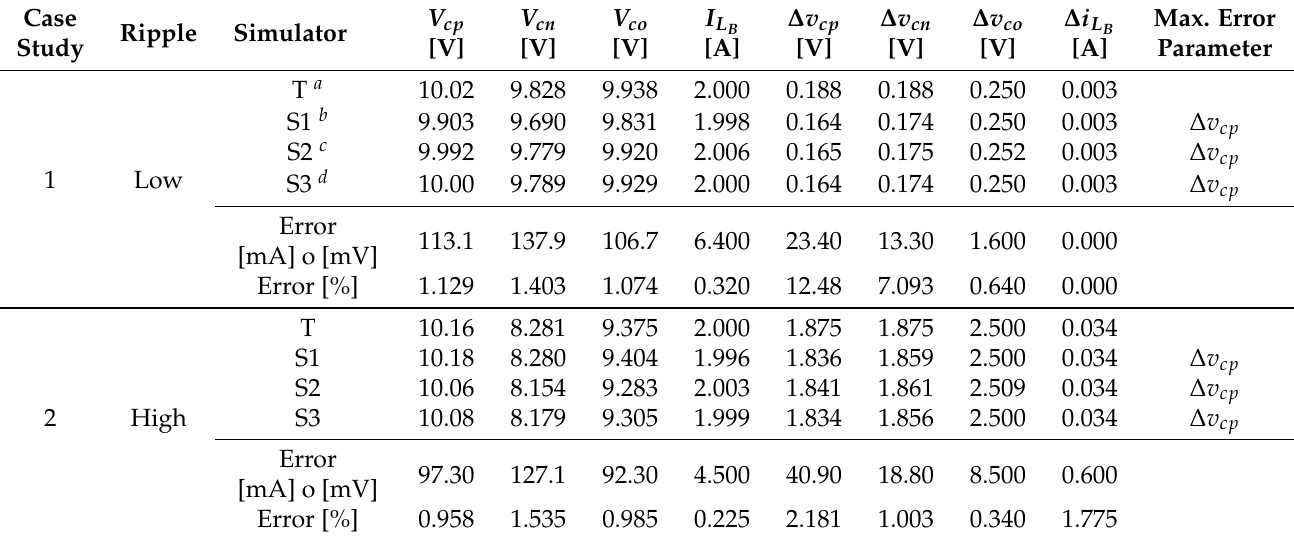
Table 3. Theoretical and simulated values of the converter with Ripple variation.